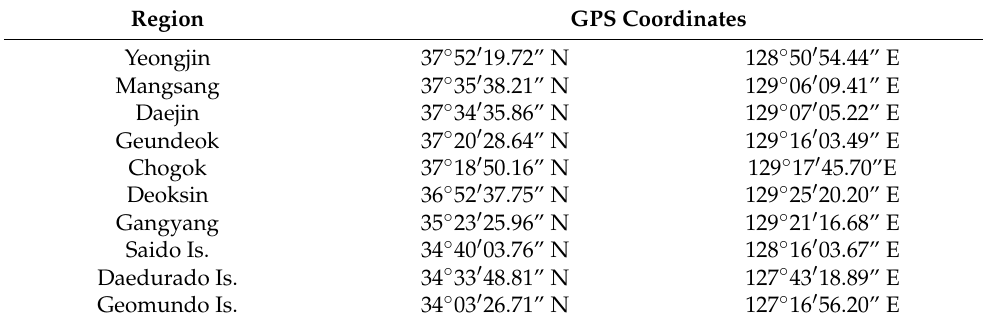
Table 1. GPS coordinates at study sites.